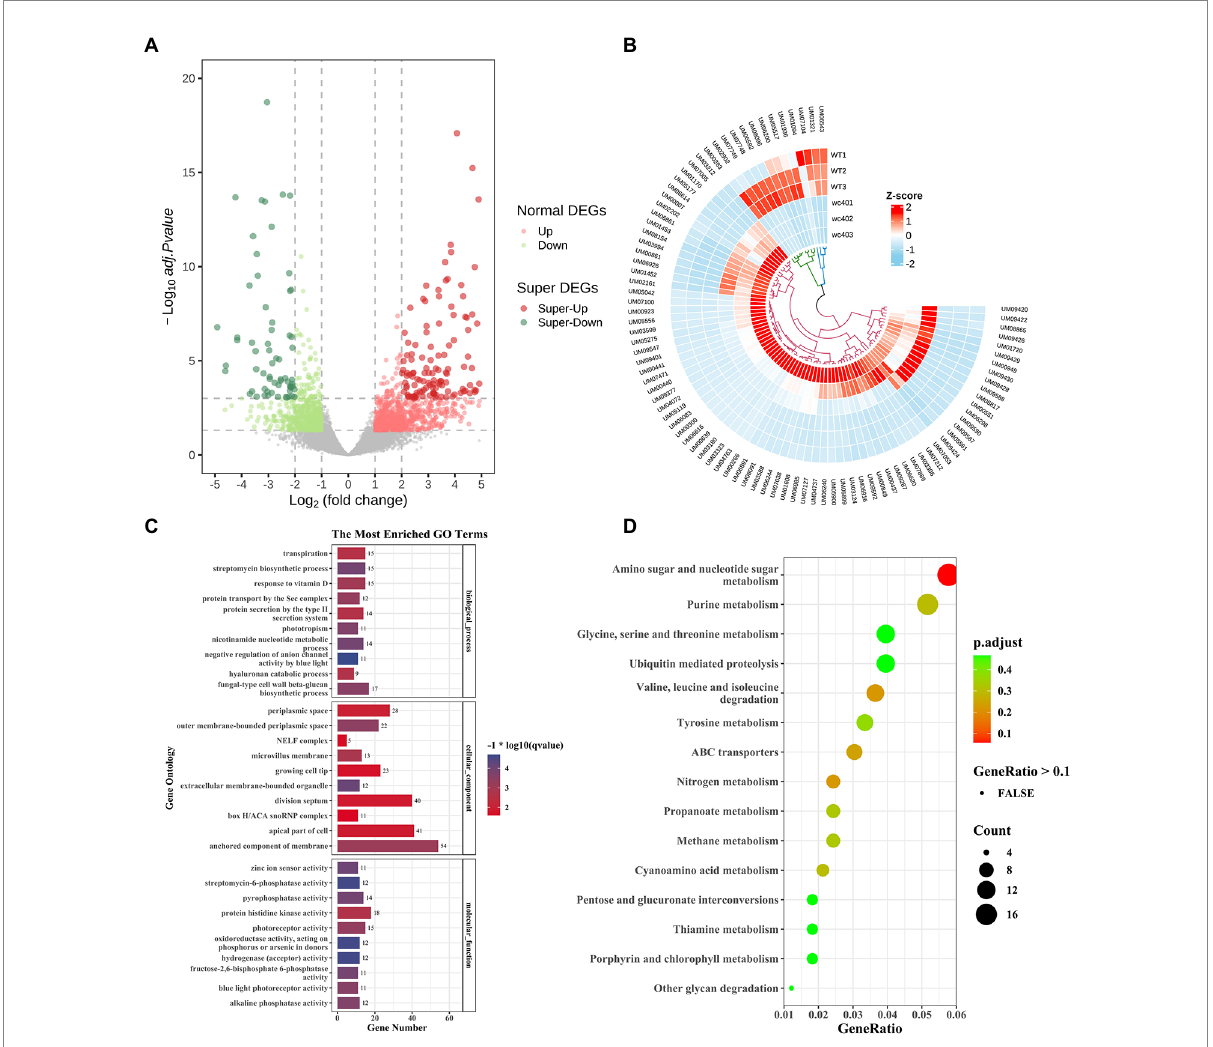
FIGURE 5 Comparative gene ontology (GO) analysis of the differentially expressed genes (DEGs) between the transcriptome of wild type and Icwc-1 mutants. (A) The volcano plot is two-dimensional, with the y -axis representing the negative log10 of the adjusted value of p , and the x -axis displays the variation ratio of each gene (log2 FC). The green spots represent significantly down-regulated genes in the mutants, while the red spots indicate up-regulated genes [false discovery rate (FDR) < 0.05]. Gray spots represent the genes that did not show differential expression. (B) The heat map shows the gene expression patterns in Icwc-1 mutants and wild-type (WT) of I. cicadae . (C) The results are summarized in three main GO categories (Cellular Component, Molecular Function and Biological Process). The x -axis indicates different mutants. The y -axis indicates the GO term. (D) KEGG enrichment analysis of the DEGs between the transcriptome of I. cicadae wild-type and Icwc-1 mutants. The y -axis indicates the KEGG pathway. The x -axis indicates the gene